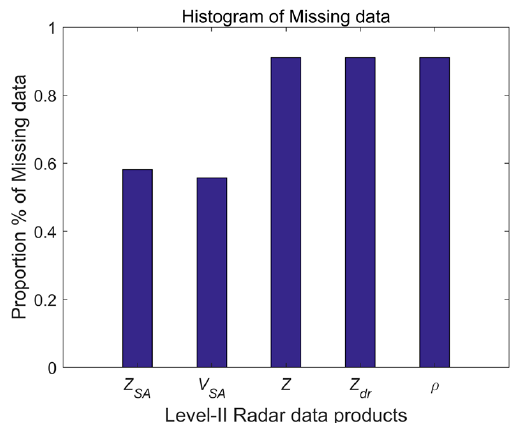
Figure 3. The proportion histogram of the missing data of level-II radar data products in raw data.